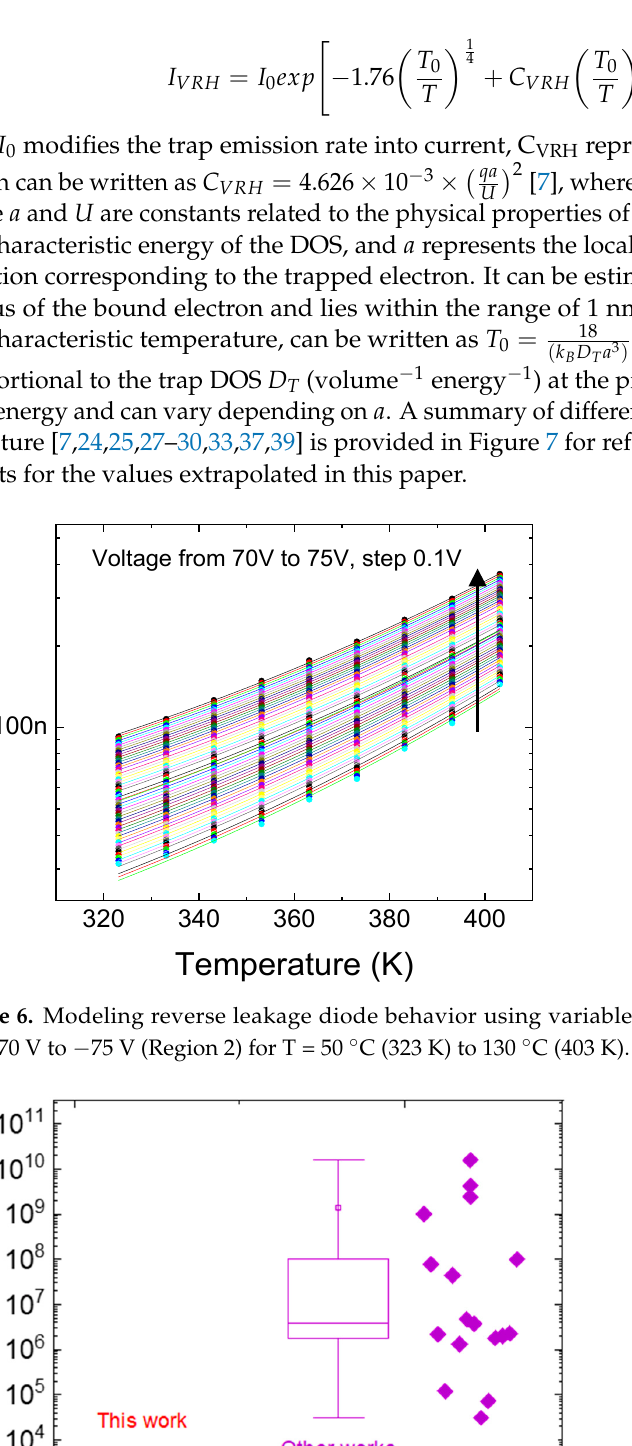
Figure 5. Comparison of the Poole–Frenkel coefficient ( β ) ≈ 10 − 5 eV V − 1/2 m 1/2 obtained from differ-